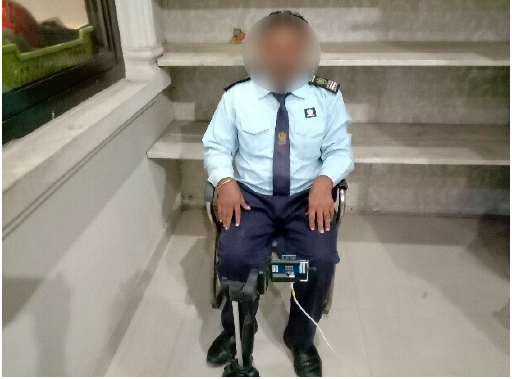
Figure 8. Subject sitting in front of the radar.